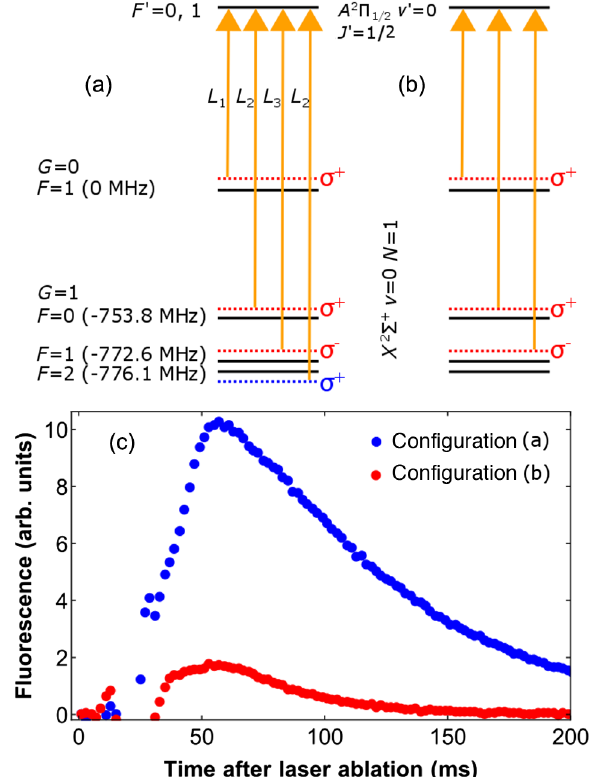
FIG. 1. The dc MOT. (a) The optimal polarization settings for all the hyperfine components for the dual-frequency MOT. For illustration purposes, we show the polarization of the beam propagating along the − z direction, and the magnetic field points along þ z at positions z > 0 [90,92]. The hyperfine structure of the excited manifold is not resolved. (b) The optimal polarization settings for the red-detuned MOT. (c) Differential MOT fluores- cence between two opposite quadrupole field directions, for the laser configurations shown in (a) and (b). We switch on a magnetic field gradient of 12 G = cm at 23 ms, and the loading process takes about 35